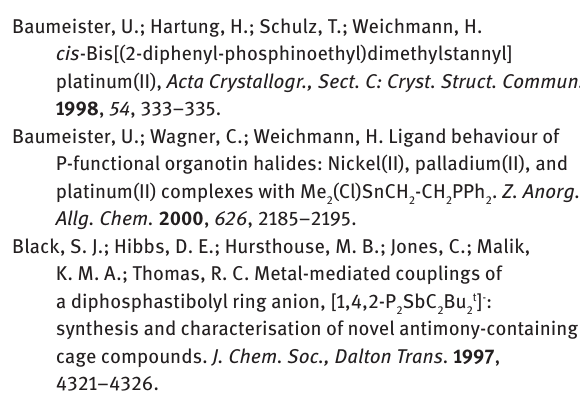
Figure 8 Structure of [(PEt (Braunstein et al.,